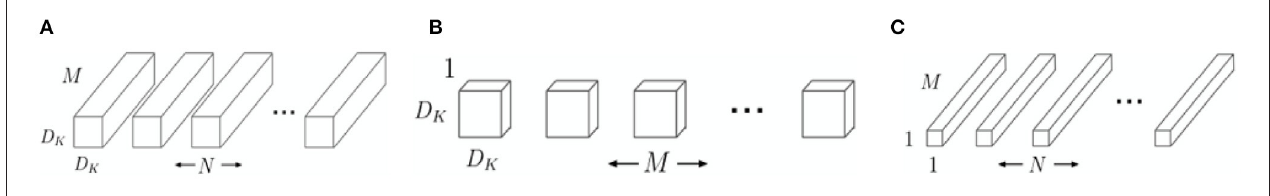
FIGURE 4 | Typical conv with depthwise conv. (A) Typical conv, (B) depthwise processing, and (C) pointwise